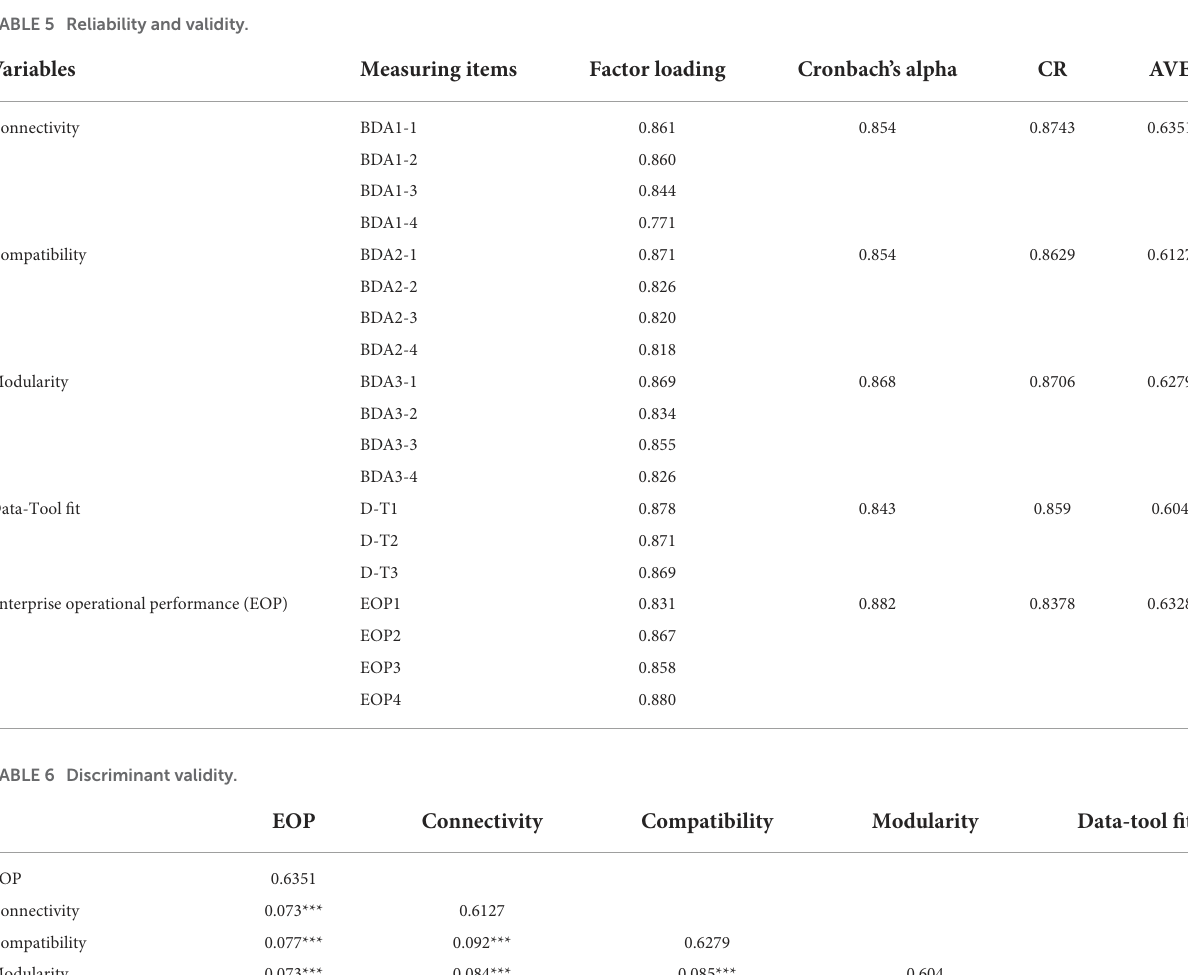
TABLE 5 Reliability and validity.